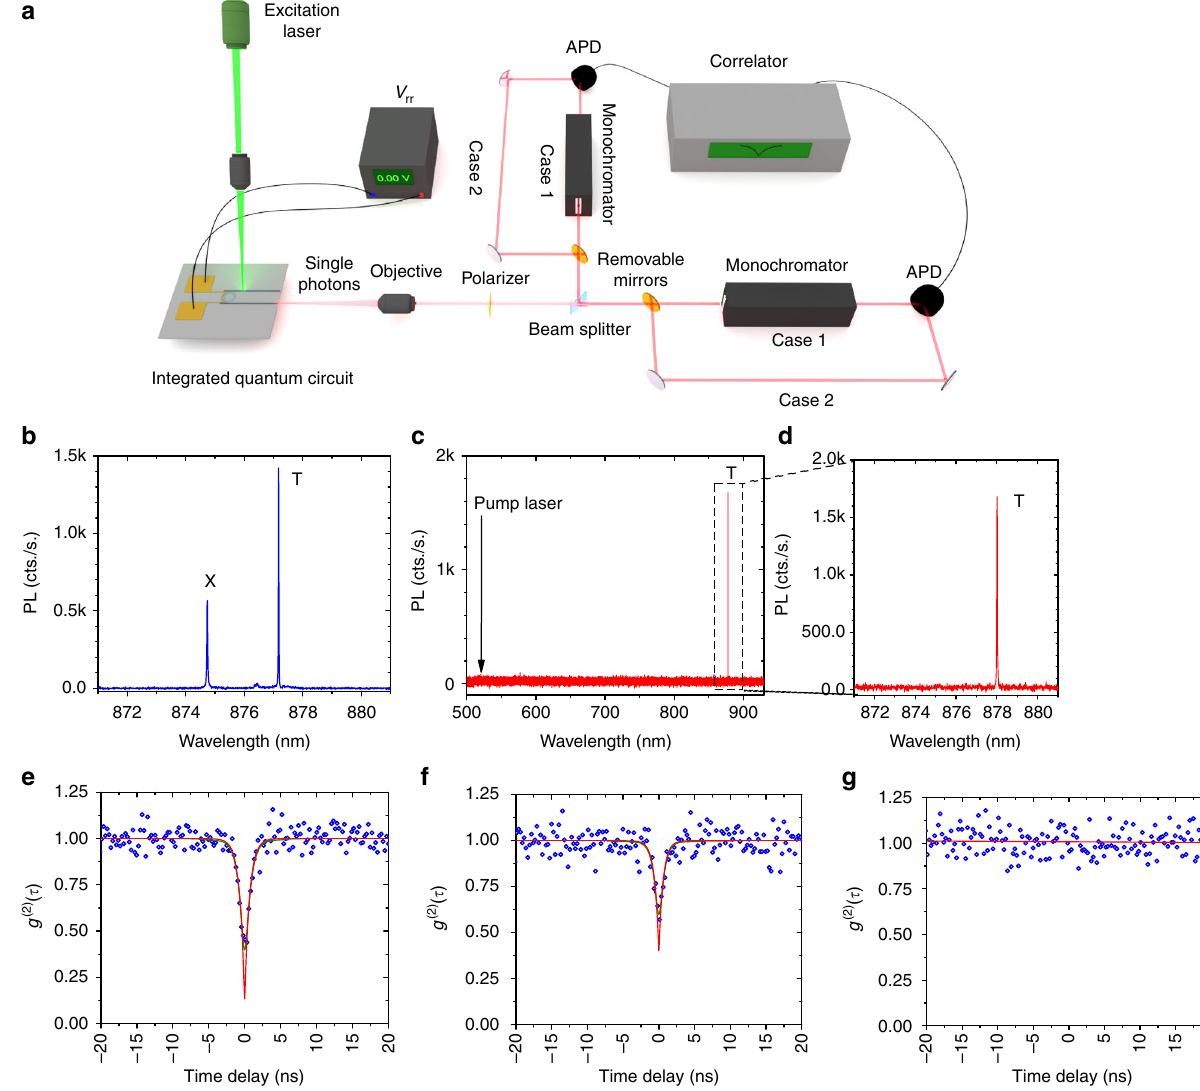
Fig. 3 On-chip fi ltering. a Experimental setup showing the hybrid integrated quantum circuit with electrical access to control the integrated fi lters. The